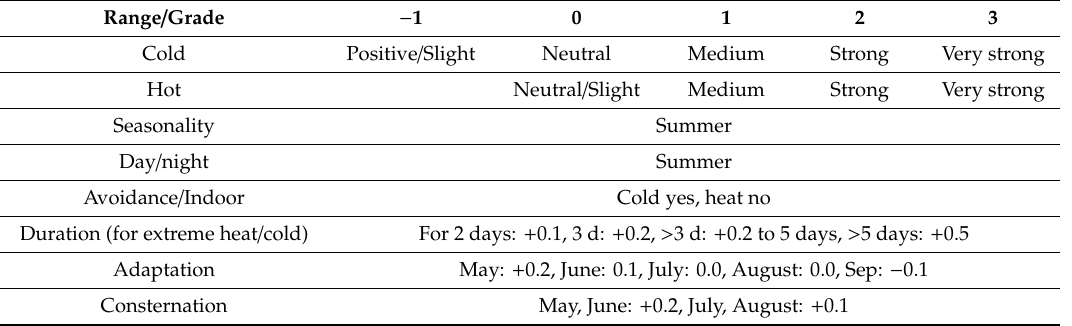
Table 1. Factors a ff ecting thermal. Months refer to northern hemisphere. Range / Grade −